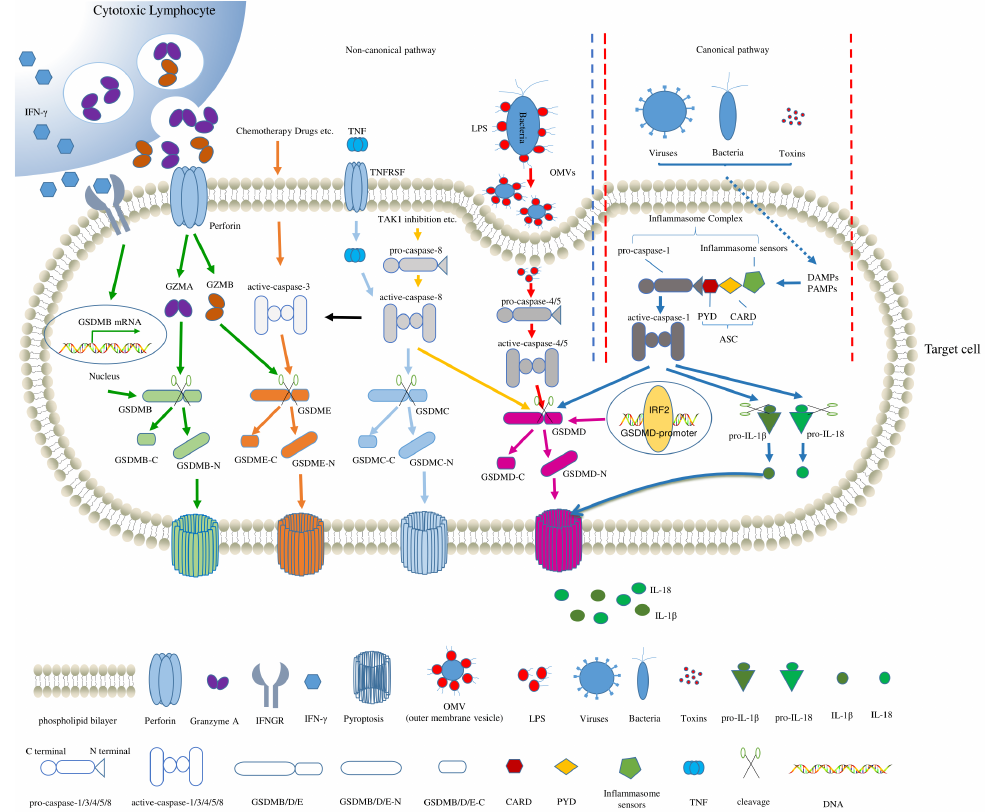
Figure 1. Schematic diagram of pyroptosis. The representative PRGs are depicted in the canonical and noncanonical pathways. For the canonical pathway (within the red dotted lines), caspase-1, activated by inflammasomes, cleaves GSDMD to release GSDMD-N, which accumulates on the cell membrane to perforate and cause pyroptosis. The inflammasome consists of an inflammasome sensor, ASC, and an effector (pro-caspase-1). Moreover, caspase-1 promotes the maturation and secretion of proinflammatory factors (IL-1 β and IL-18), which leads to the expansion of the inflammatory response. For the noncanonical pathway (left to the blue dotted lines), pyroptosis is mainly mediated by caspase-4/5, which cleaves GSDMD to induce pyroptosis. In addition, caspase-3/8 cleaves GSDME, and lymphocyte-derived granzyme A (GZMA) cleaves GSDMB to induce pyroptosis. The α -ketoglutarate increases the ROS levels to induce the oxidation and internalization of the plasma-membrane-localized death receptor, DR6, which recruits and activates both pro-caspase-8 and GSDMC to induce